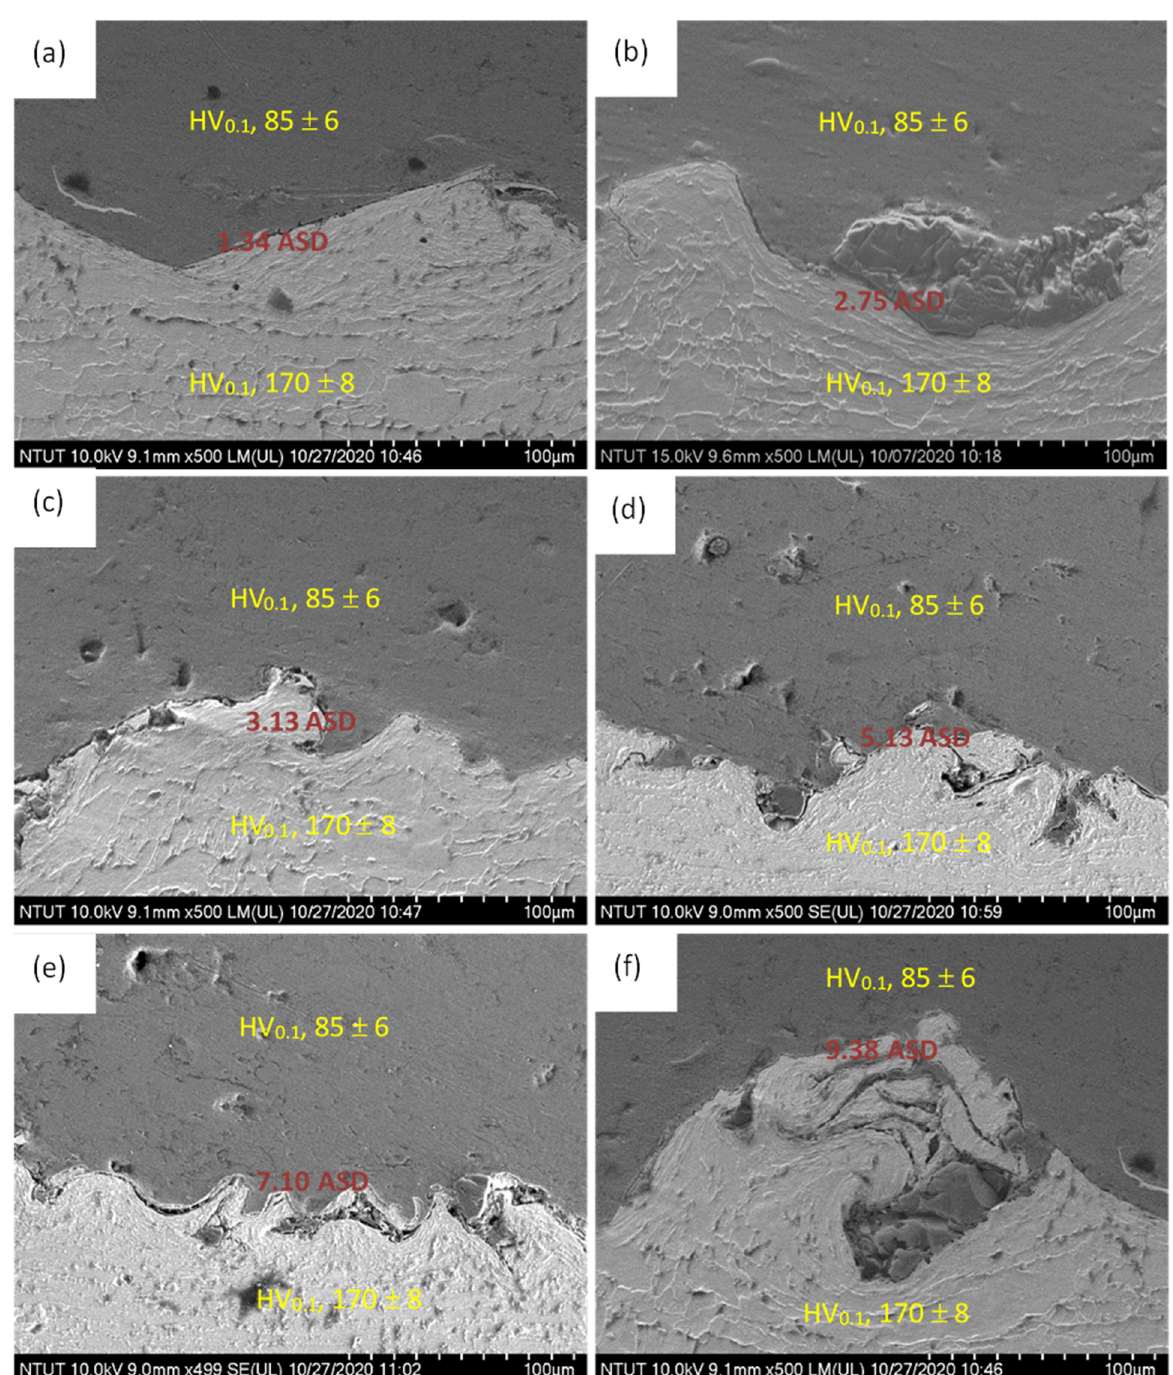
Figure 11. SEM images of AISI 1045/thermally sprayed Al interface after application of current densities: ( a ) 1.34 ASD, ( b ) 2.75 ASD, ( c ) 3.13 ASD, ( d ) 5.13 ASD, ( e ) 7.10 ASD, and ( f ) 9.38 ASD. Microhardness values (HV 0.1 for AISI 1045 and HV 1.0 for hardened surface) were given for comparison.